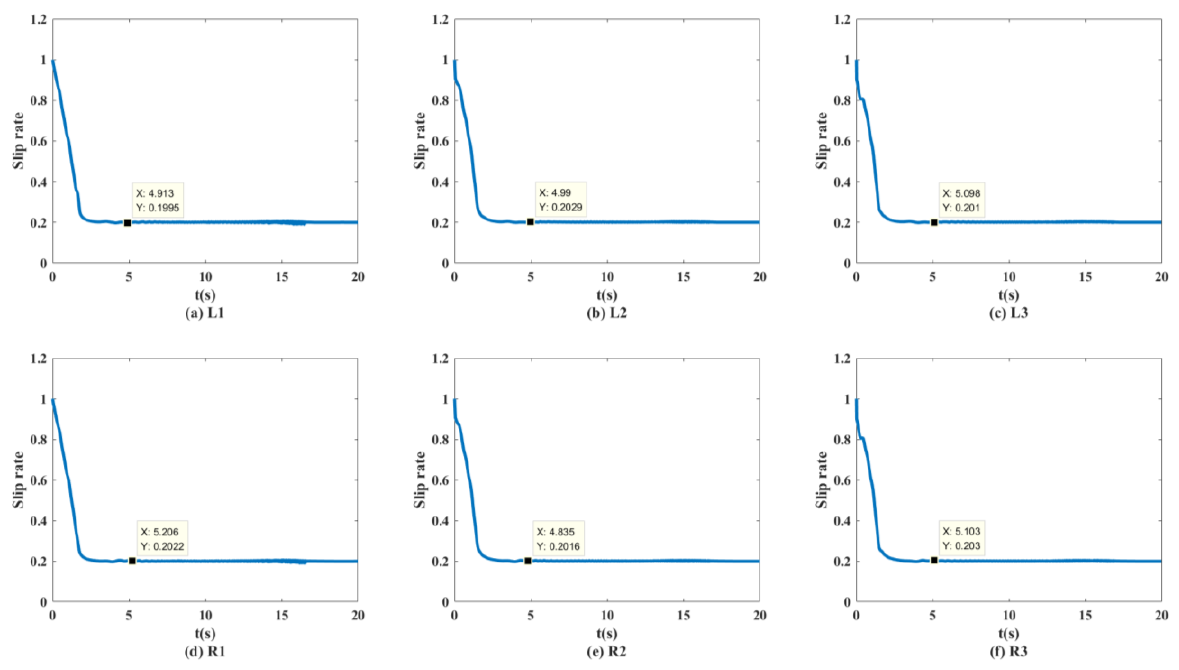
Figure 23 . Wheel slip rate of distributed unmanned vehicles at 50 km/h on the sine sweep straight road .